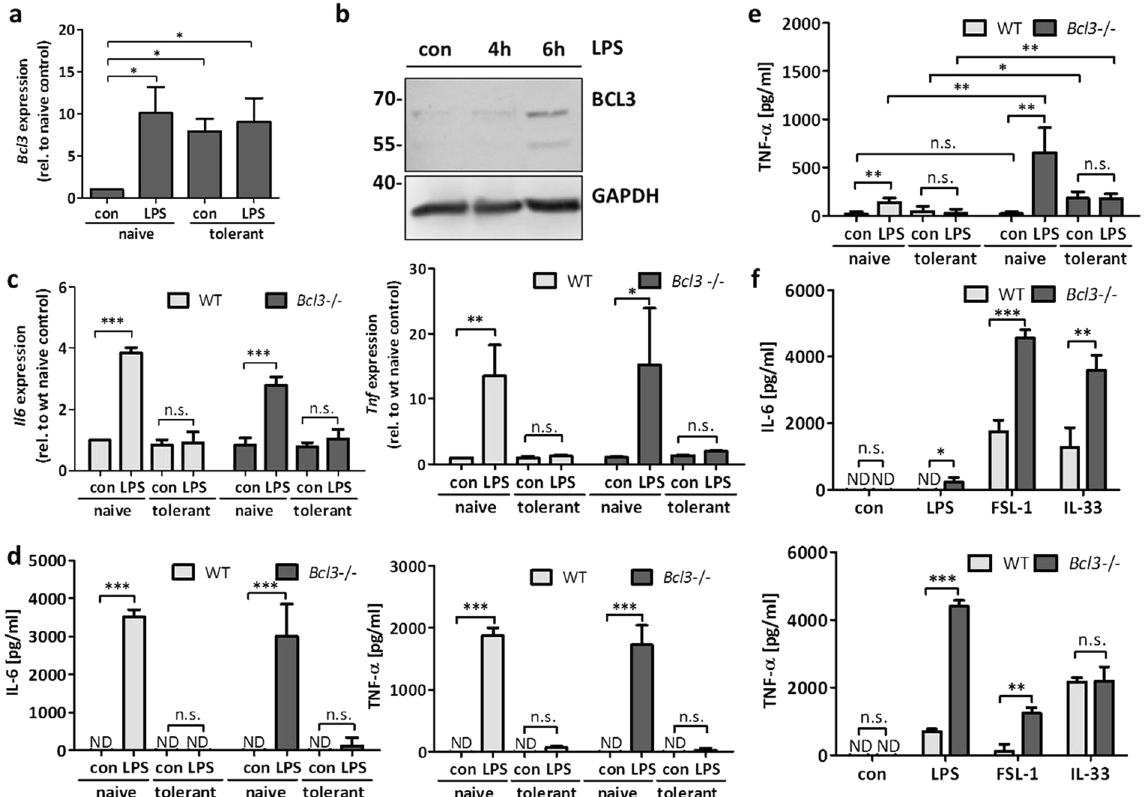
Figure 8. BCL3 controls cytokine production in PMCs without altering the quality of ET. BMMCs were left untreated or incubated with LPS (300 ng/ml) for 24 h to induce ET. Naive and tolerant BMMCs were then stimulated with LPS (1 µ g/ml) for 90 min and Bcl3 gene expression was analysed ( a ). Data show mean ± SD from n = 3 independent experiments. One-sample t -Test was performed to calculate the p-values. Moreover, cells were stimulated with LPS (1 µ g/ml) for 4 h and 6 h and lysates were analysed by Western Blotting with antibodies specific for BCL3 and GAPDH (loading control) ( b ). The Western blot is representative of three independent experiments with three biological samples. Next, BMMCs of WT and Bcl3 − / − mice were pretreated with LPS (300 ng/ml) for 24 h to induce ET. Then the cells were stimulated with LPS (1 µ g/ml) for 90 min to measure Il6 and Tnf mRNA expression ( c ), and for 4 h to detect IL-6 and TNF- α protein secretion ( d ). Also, WT and Bcl3 − / − PMCs were incubated with LPS (300 ng/ml) for 24 h to induce ET, and then stimulated with LPS (1 µ g/ml) for 4 h to analyse TNF- α protein production ( e ). Moreover, WT and Bcl3 − / − PMCs were stimulated with LPS (1 µ g/ml), FSL-1 (1 µ g/ml), and IL-33 (2 ng/ml) for 4 h and IL-6 and TNF- α protein secretion was measured ( f ). Data show mean ± SD from three independent experiments. Student’s t -Test and one-sample t -Test were performed to calculate the p-values. Multiple testing p-values were corrected by FDR. * p < 0.05, ** p < 0.01, *** p <